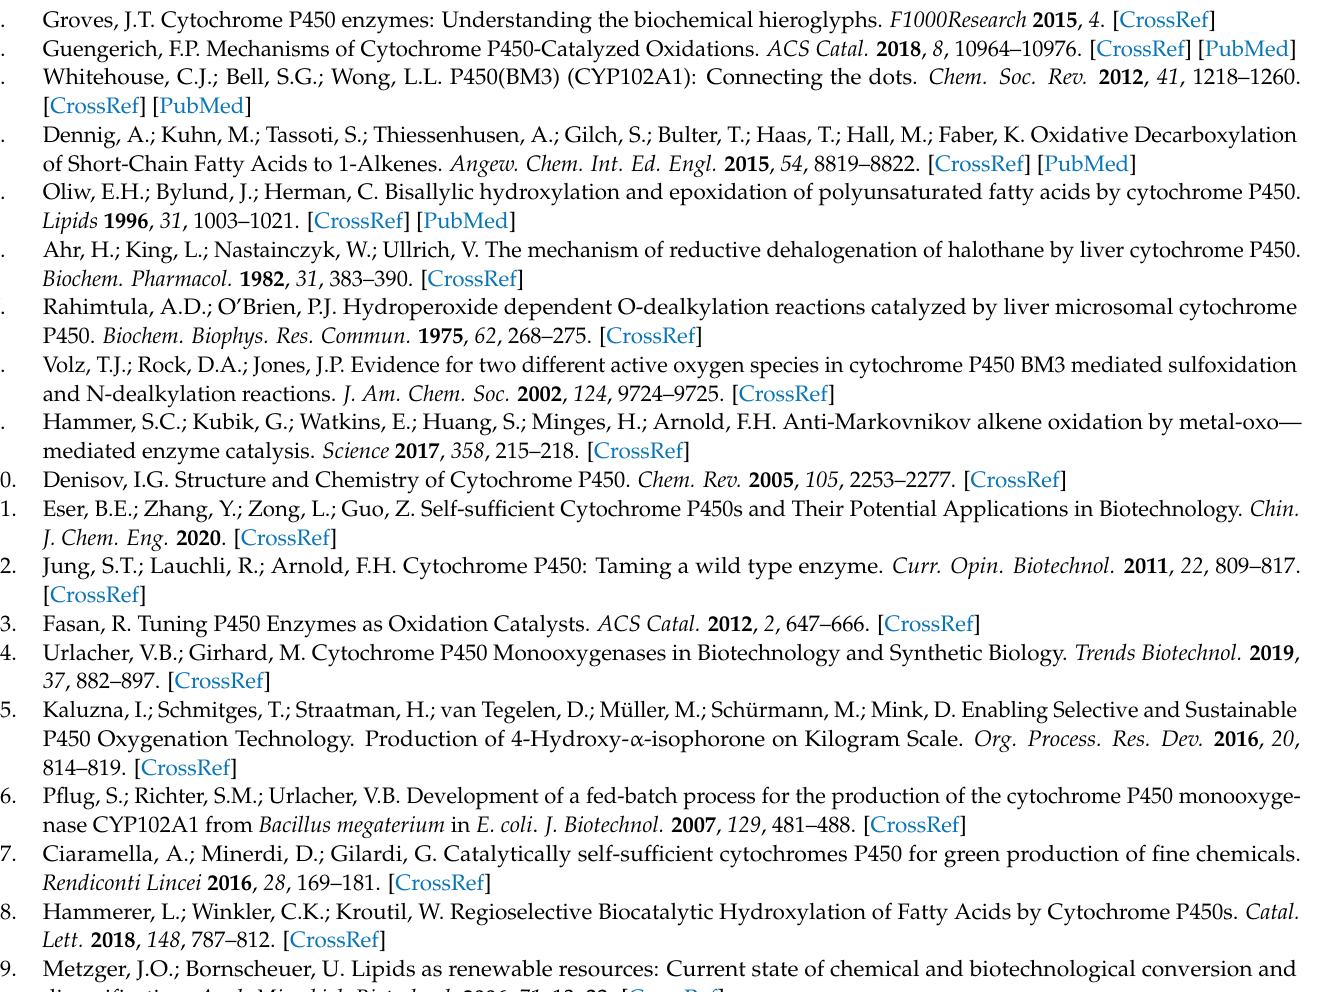
Table S2: Numerical data for temperature dependence experiments, Table S3: Numerical data for pH dependence experiments, Table S4: Numerical data for thermostability measurements, Table S5: Total conversion levels and regioselectivity data for the hydroxylation of different substrates by wild-type and rational design mutants of BAMF2522, Table S6: Comparison of the mutated residue positions in the protein sequences of BM3 and